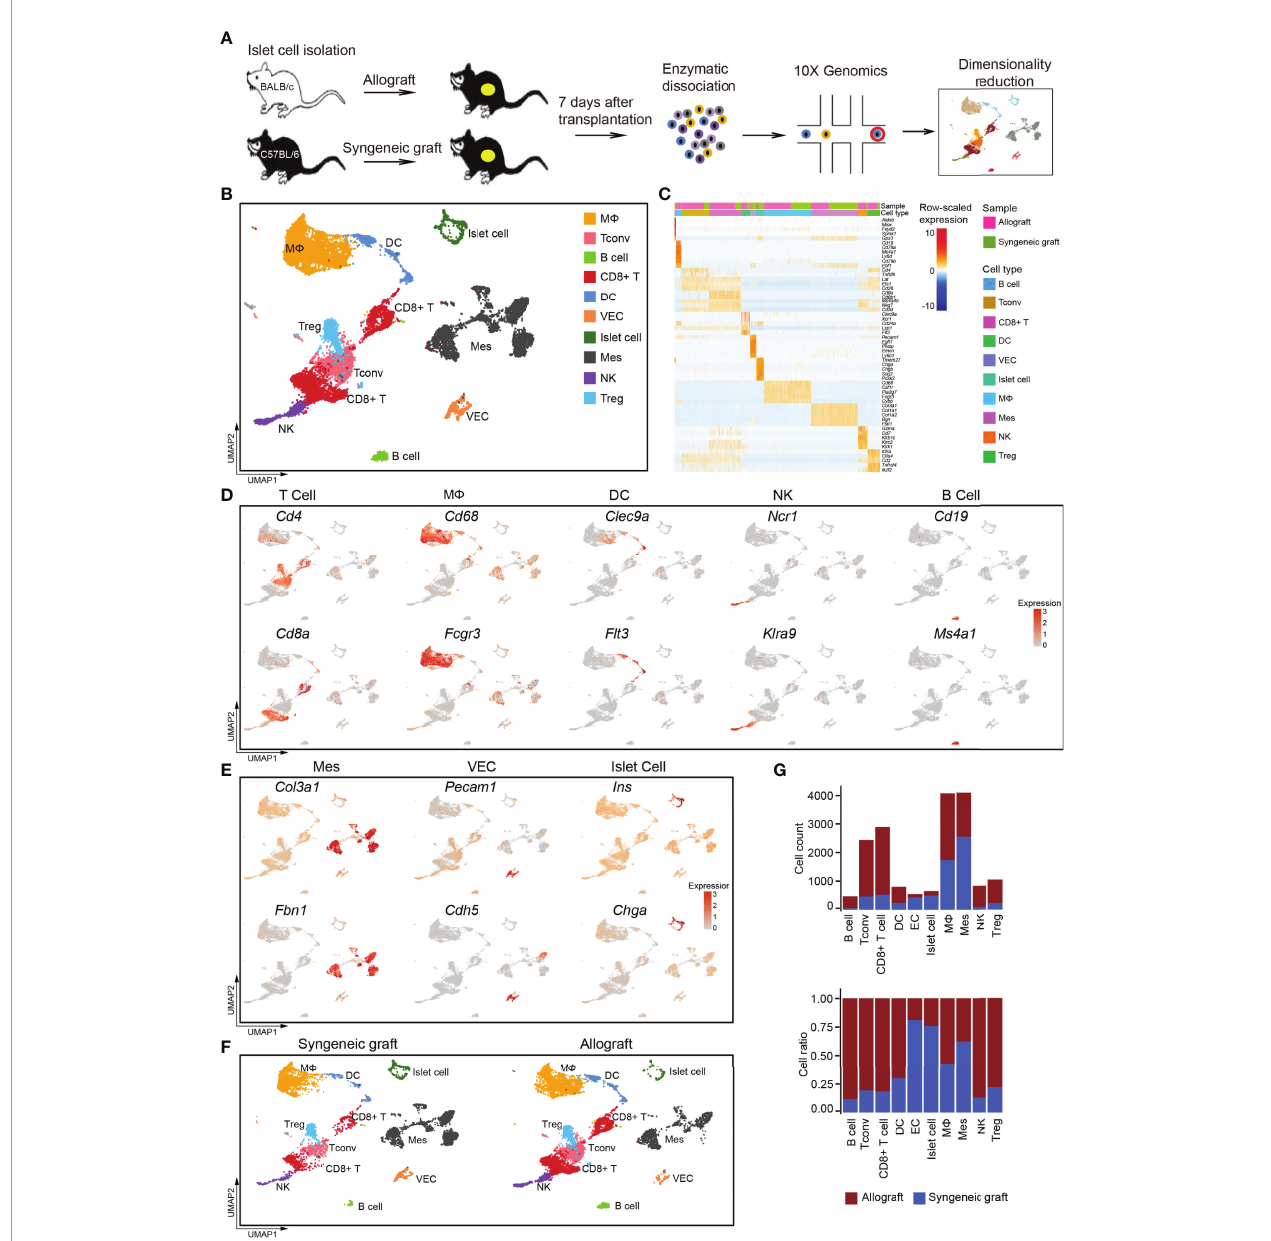
FIGURE 1 | Overview of the components of cells in islet cell grafts 7 days post-transplantation by single-cell RNA-seq. (A) Schematic of the experimental design, single-cell sequencing, and analysis. (B) UMAP visualization of the total cells pro fi led here, with each cell colorcoded for the associated cell type. (C) Heatmap of row-scaled expression of marker gene expression within de fi ned populations. Expression was measured in units of log2. (D) UMAP visualization shows the expression of marker genes for T cells, macrophages, dendritic cells (DCs), natural killer cells (NKs), and B cells. (E) UMAP visualization shows the expression of marker genes for mesenchymal cells, vascular endothelial cells, and islet cells. (F) UMAP visualization of the total cells from the syngeneic graft (left) and allograft (right), with each cell colorcoded for the associated cell type. (G) The number (upper panel) and a fraction (lower panel) of cells in the indicated cell type. Syngeneic graft n = 5, allograft n = 5. Analysis of gene expression in scRNA-seq data was performed in R using Seurat. VEC, vascular endothelial cell; Mes, mesenchymal cell; Tconv, conventional T